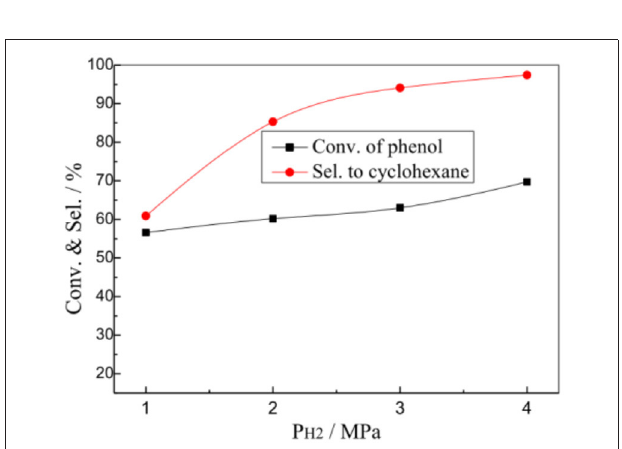
FIGURE 8 | Effect of t R on the HDO of phenol over 1%Pt/SBA-Pr. Reaction conditions: P H2 , 4.0 MPa, TR, 200 ◦ C; 800 rpm, 0.0125mol PhOH in 25.0mL CH 2 Cl 2 , 0.9756g 1%Pt/SBA-Pr (n Pt :n PhOH =